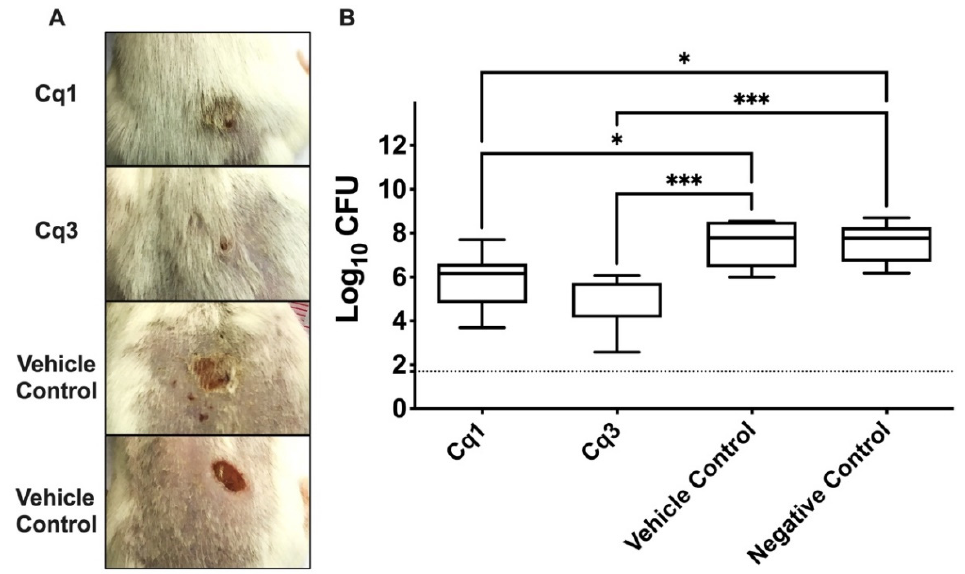
Figure 3. Efficacy of Caralluma quadrangula extracts (Cq1 and Cq3) in an in vivo murine model of MRSA skin infection. Thirty-two BALB/C mice were divided into four groups (n = 8), three treated groups (Cq1, Cq3, and vehicle), and the fourth group remained untreated as the negative control. ( A ) Efficacy of Caralluma quadrangula extracts (Cq1 and Cq3) on MRSA skin infection in the posterior upper backs of mice at the end of the experiment. ( B ) Efficacy of Caralluma quadrangula extracts on the bacterial load in murine model MRSA skin infection. Results are expressed as mean ± standard error. The dotted line represents the limit of detection of the viable count (log10 of 50 CFU = 1.7). * and *** indicate that the difference is significant at p < 0.05 and p < 0.0009, respectively (one-way ANOVA, Tukey’s post-hoc test).